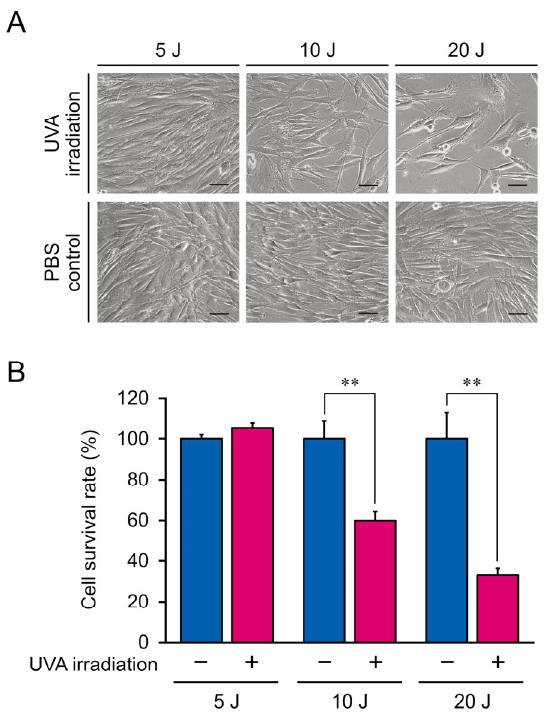
Figure 2. ( A ) Morphological characteristics of NB1RGB fibroblasts irradiated with 5, 10, or 20 J/cm 2 ultraviolet A (UVA). Inset scale bar, 50 µm. ( B ) Optical density of NB1RGB fibroblasts irradiated with 5, 10, or 20 J/cm 2 UVA. The mean ± SEM of a representative result from independent experi- ments performed in quadruplicate. Asterisks indicate significant differences analyzed with Stu- dent’s t -test, ** p < 0.01 vs. UVA non-irradiation group as a control at different UVA doses.